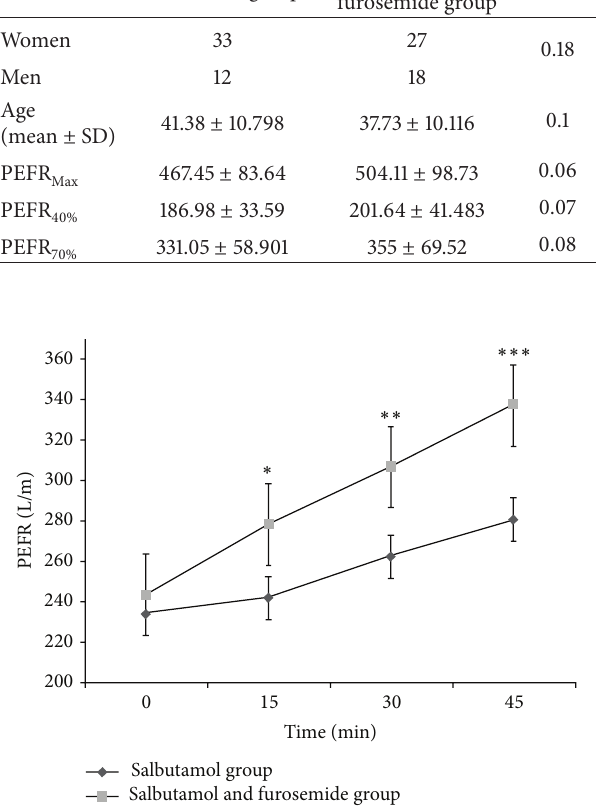
Figure 1: Comparison of mean ( ± SD) peak of the expiratory flow rate (PEFR) of nebulized salbutamol (𝑛 = 45) and nebulized salbutamol with furosemide (𝑛 = 45) based on time. ( ∗ 𝑃 = 0.03 , ∗∗ 𝑃 = 0.01 , and ∗∗∗ 𝑃 = 0.001 ).